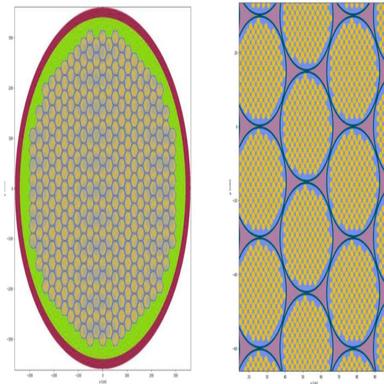
Radial view of the MSR design. Left: The entire core is shown with the graphite surround (green) and the stainless-steel containment vessel (red). Right: A closer view of the graphite pebble channels is shown. (For interpretation of the references to colour in this figure legend, the reader is referred to the web version of this article.)